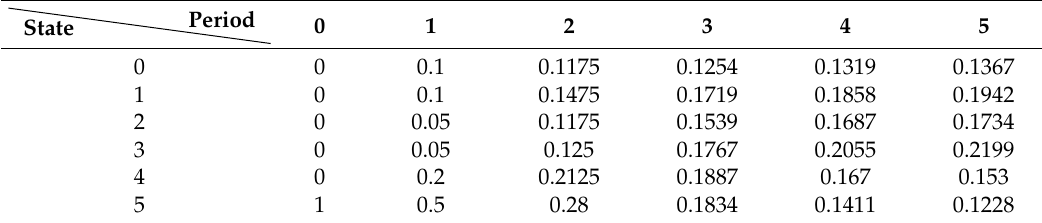
Table A5. Probability distribution of component 5 using the SMV approach.